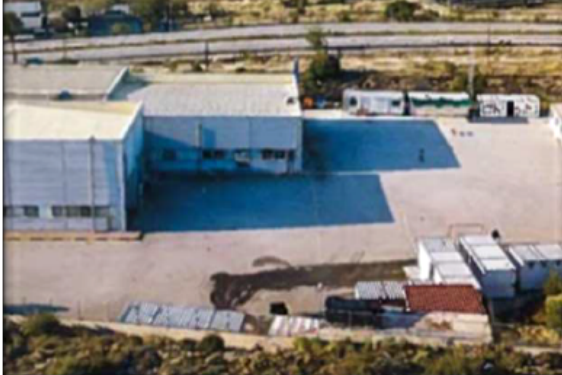
Figure 3. Moza camp in Volos, September 2020. Source: International Organization of Migration